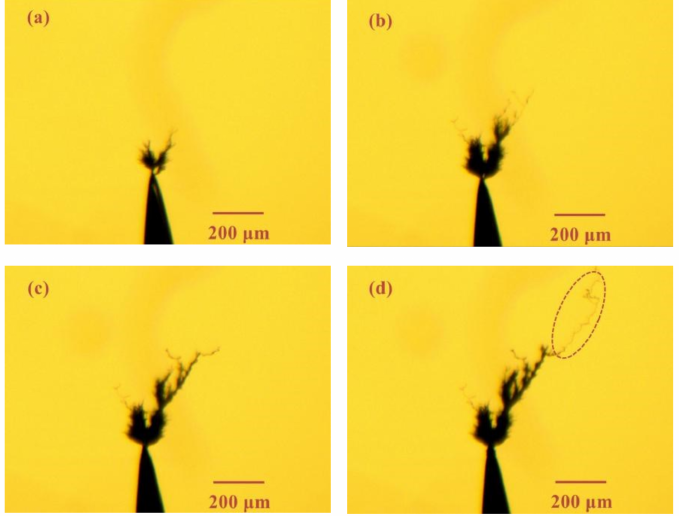
Figure 6. Electrical tree morphology in epoxy casting insulation sample with small air gap under 20 kHz / 8 kV bipolar square-wave voltage at time of ( a ) 1 min, ( b ) 5 min, ( c ) 10 min, ( d ) 15